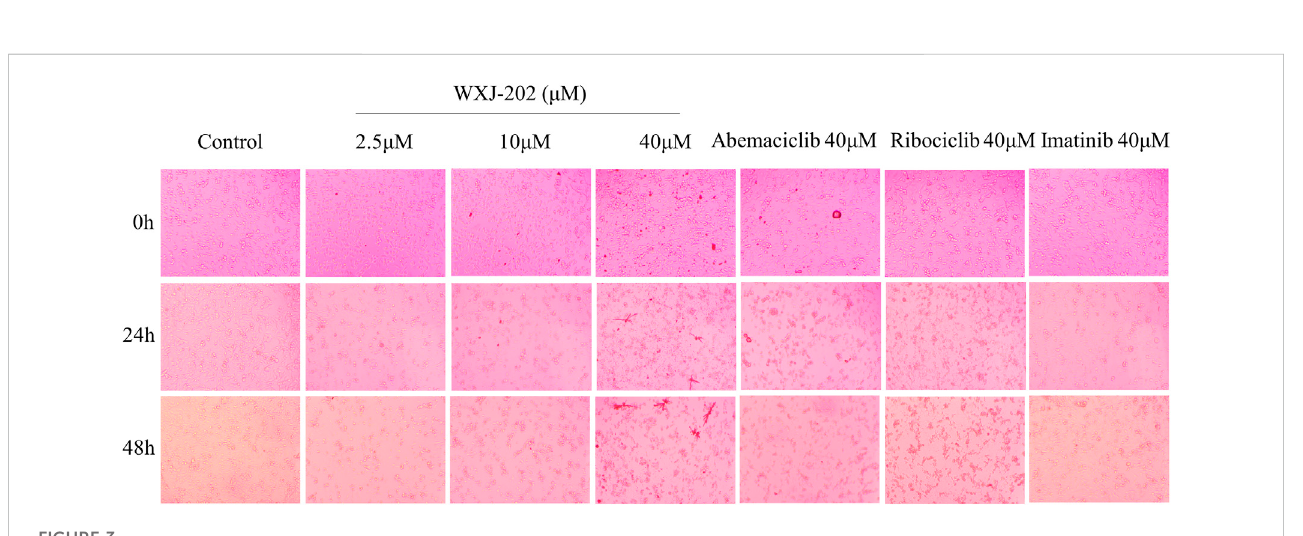
FIGURE 3 Effects of different concentrations of compound WXJ-202 on the morphology of MDA-MB-231